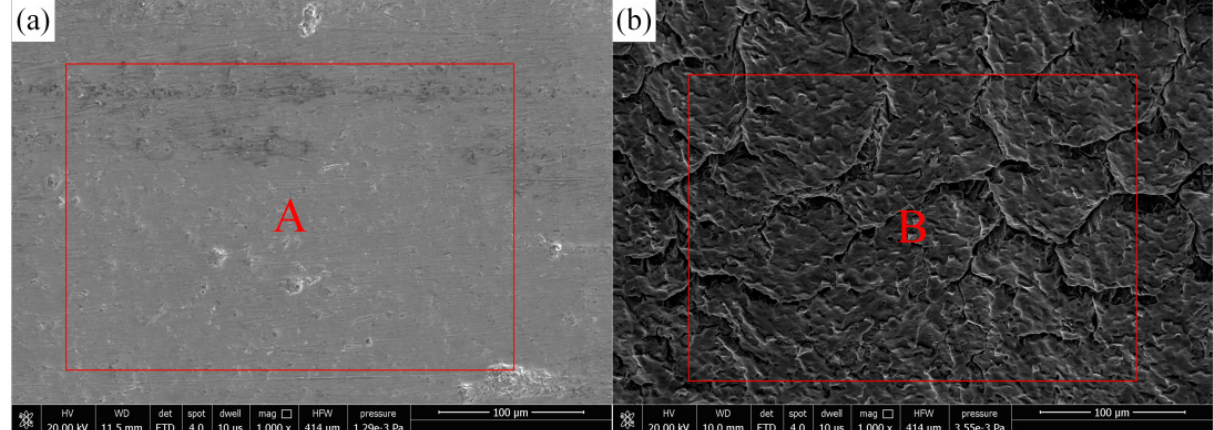
Figure 5. SEM of Ablation Surface of Microgroove and Original Surface of Substrate. ( a ) SEM of the original surface of the sample, ( b ) SEM of sample microgroove surface.